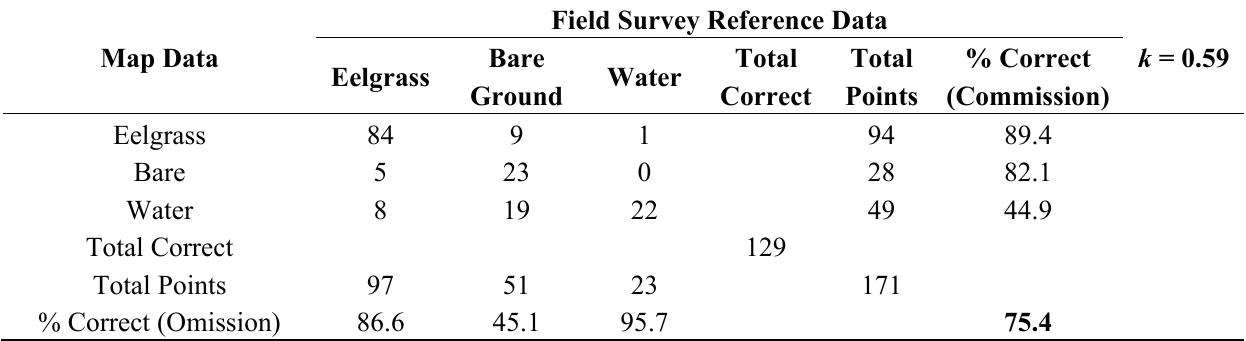
Table A14. Final product for classification of habitats in Kinzarof Lagoon.